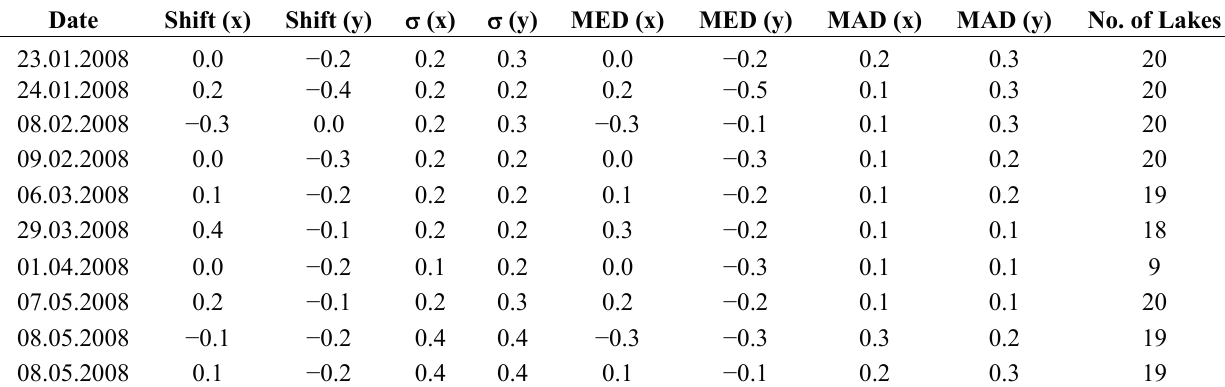
Table 4. Absolute accuracy evaluation; statistical summary from the lake shifts in AVHRR images acquired from NOAA-17. All values are in pixels except the number of lakes and are derived from signed